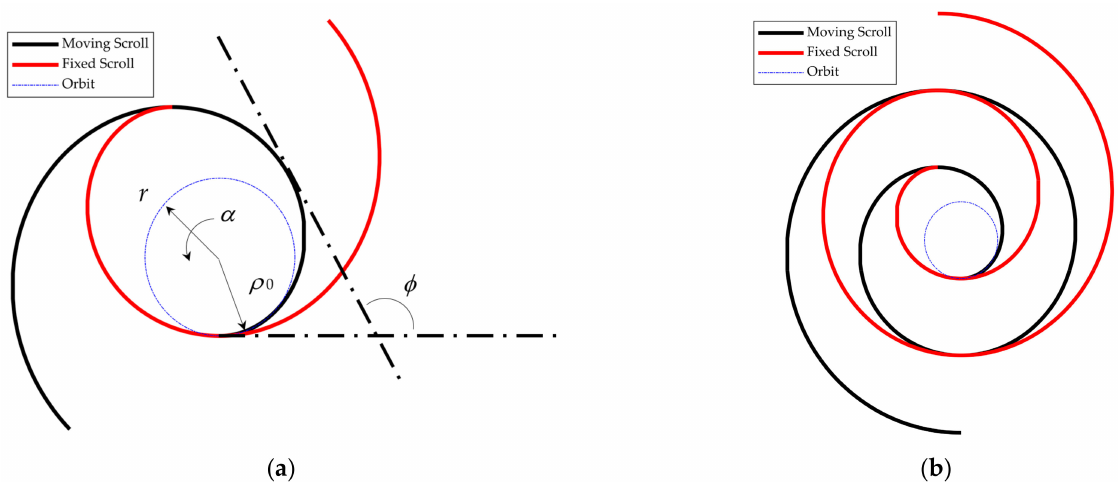
Figure 2. ( a ) Geometry definition for the scroll compressor blades; ( b ) scroll-type air compressor blade geometry. The moving scroll orbits on a fixed path and is enveloped by the fixed scroll. Air is compressed as it moves inwards from the inlet to the central outlet